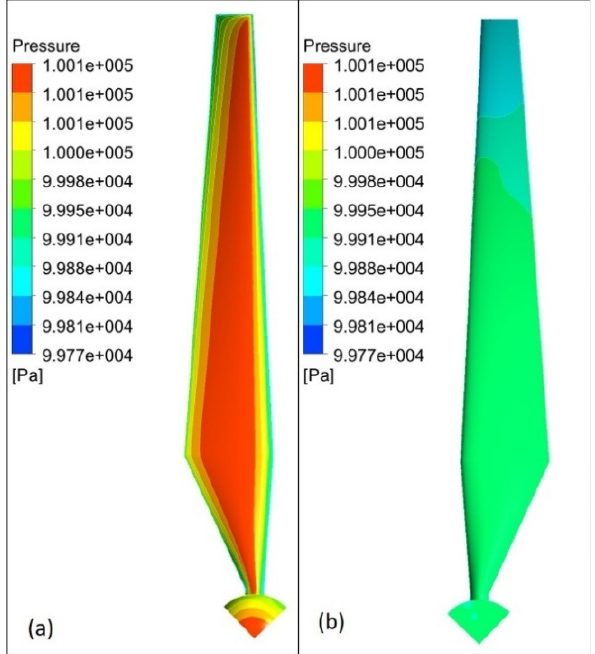
Figure 10. Pressure distribution on the leading ( a ) and rear ( b ) face of the blade at 15 m/s.